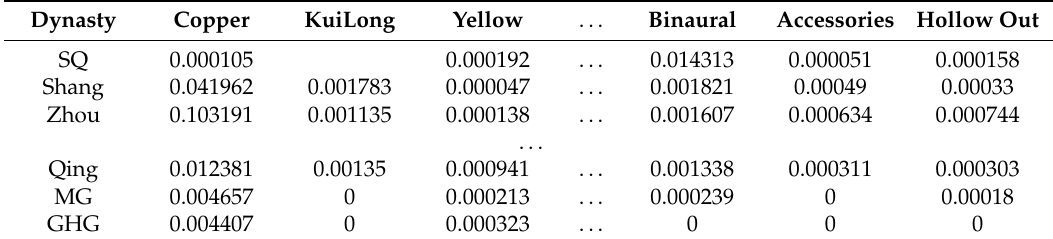
Table 1. Vector matrix of cultural memes in